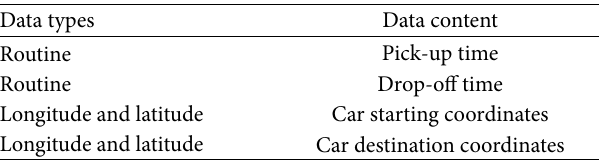
Table 2: GPS data